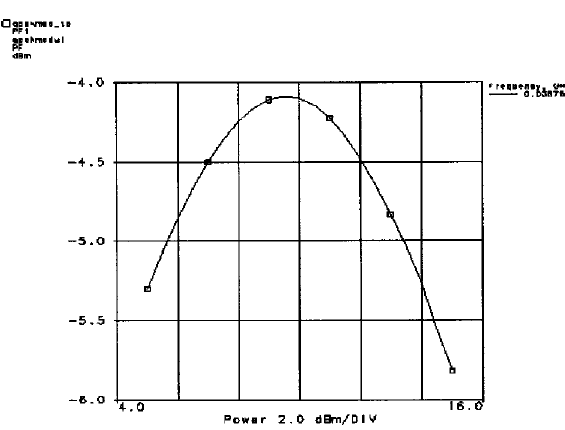
FIGURE 28 Power of the first harmonic of the output signal ð 10 : 03875GHz Þ vs. the power of the LO